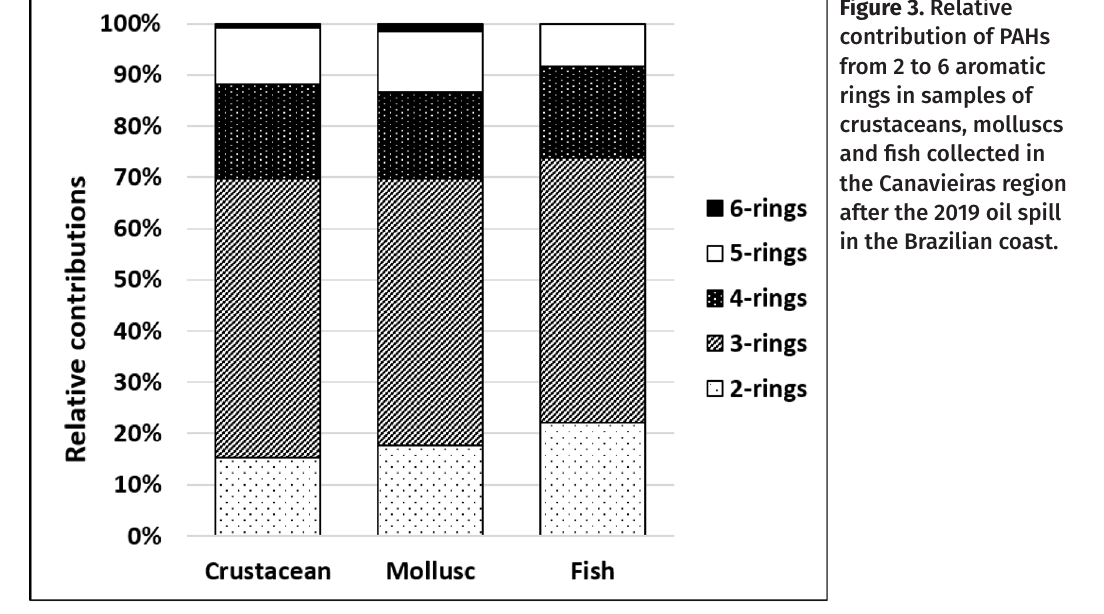
Figure 3. Relative contribution of PAHs from 2 to 6 aromatic rings in samples of crustaceans, molluscs and fish collected in the Canavieiras region after the 2019 oil spill in the Brazilian